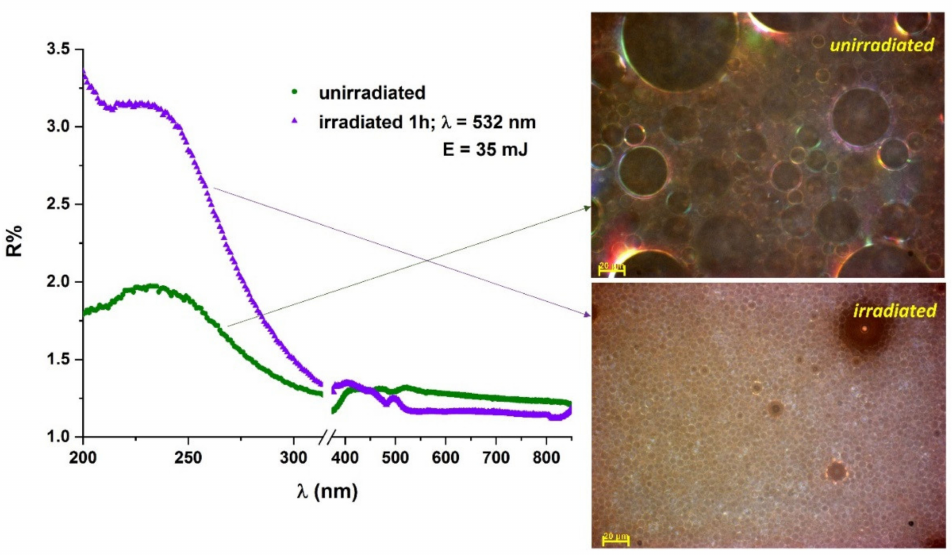
Figure 6. UV-Vis absorbance spectra of vitamin A and STS 10% emulsion, 1:1 ratio, before and after exposure to laser radiation. Optical microscopy images (reflected light-DIC mode, 50X magnification) of the same